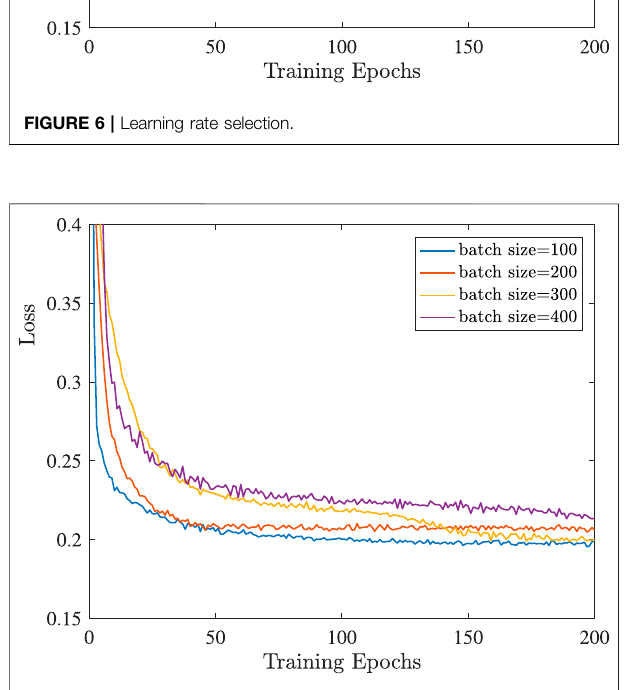
FIGURE 5 | Average utility of users versus q 1 .